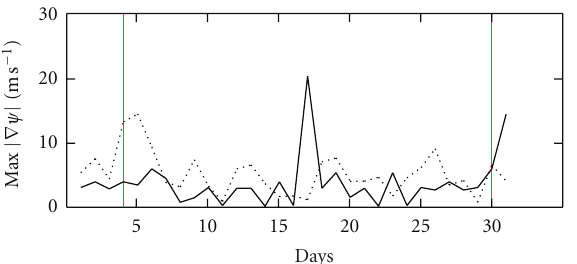
Figure 7: As in Figure 6, except for the maximum |∇ ψ | (ms − 1 ) calculated following [10] for July 2010 in the blocking domain D